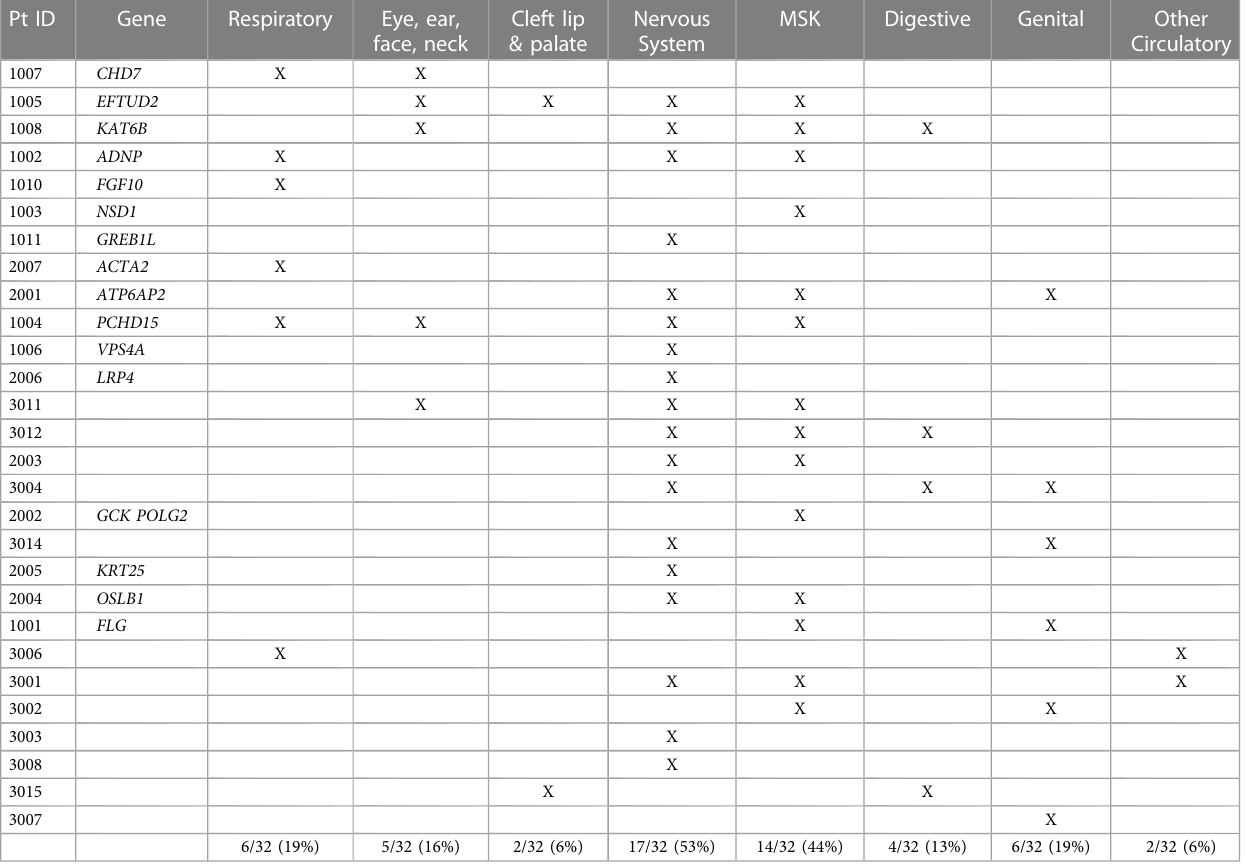
TABLE 5 Additional organ systems with structural congenital